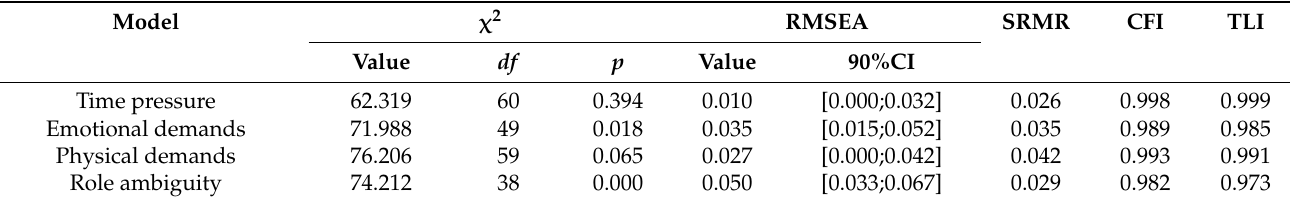
Table 2. Fit statistics for the measurement